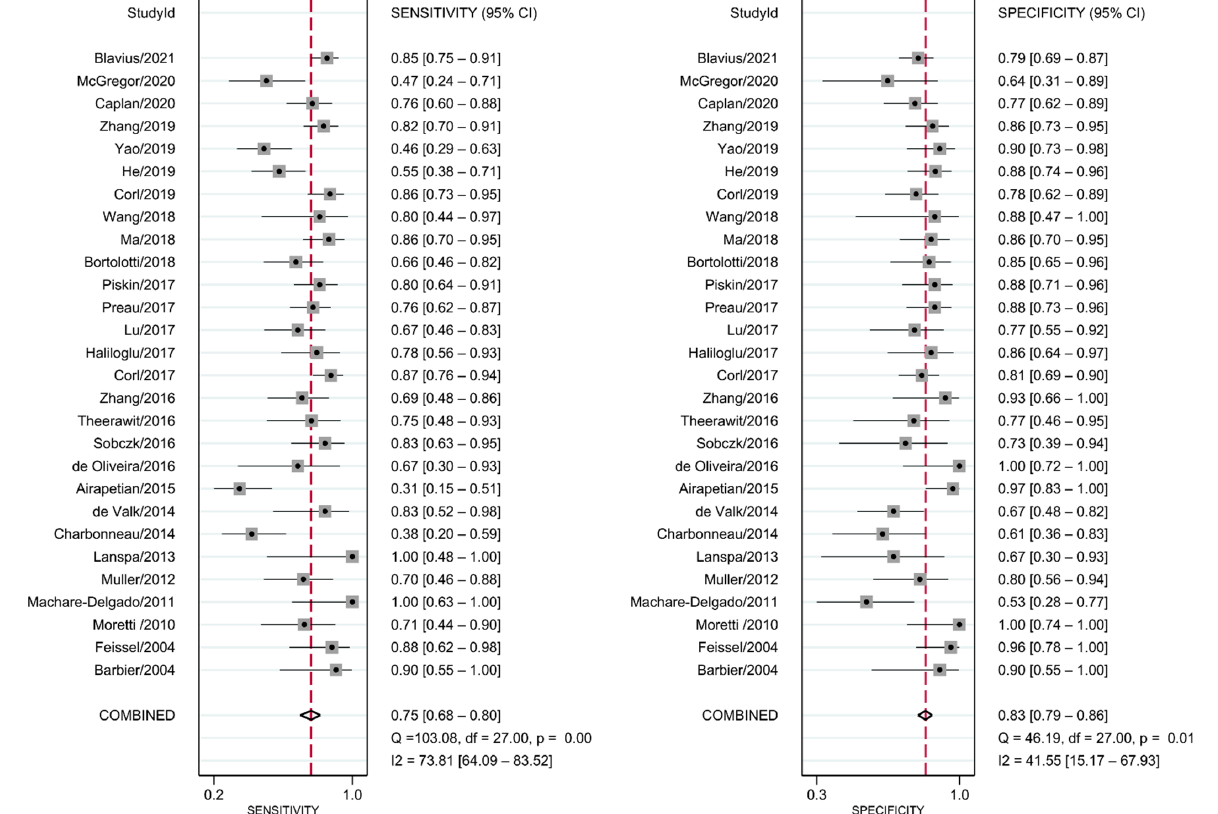
Figure 2. Forest plot for pooled sensitivity and specificity of respiratory variability of IVC diameter.